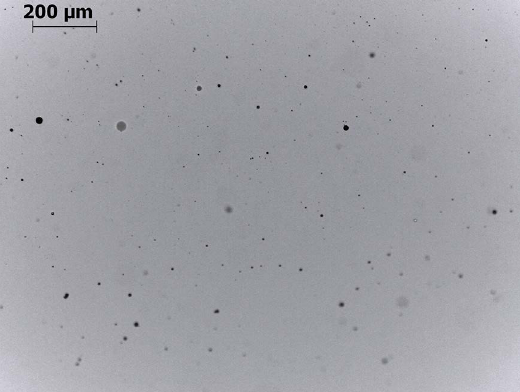
Figure 10 . Images obtained by OM of the oil-water emulsion with a concentration of 200ppm. Fig. 11 shows the results of the water/oil flow measurement test through the porous membrane support under the pressure of 1.0 bar for all membranes produced.